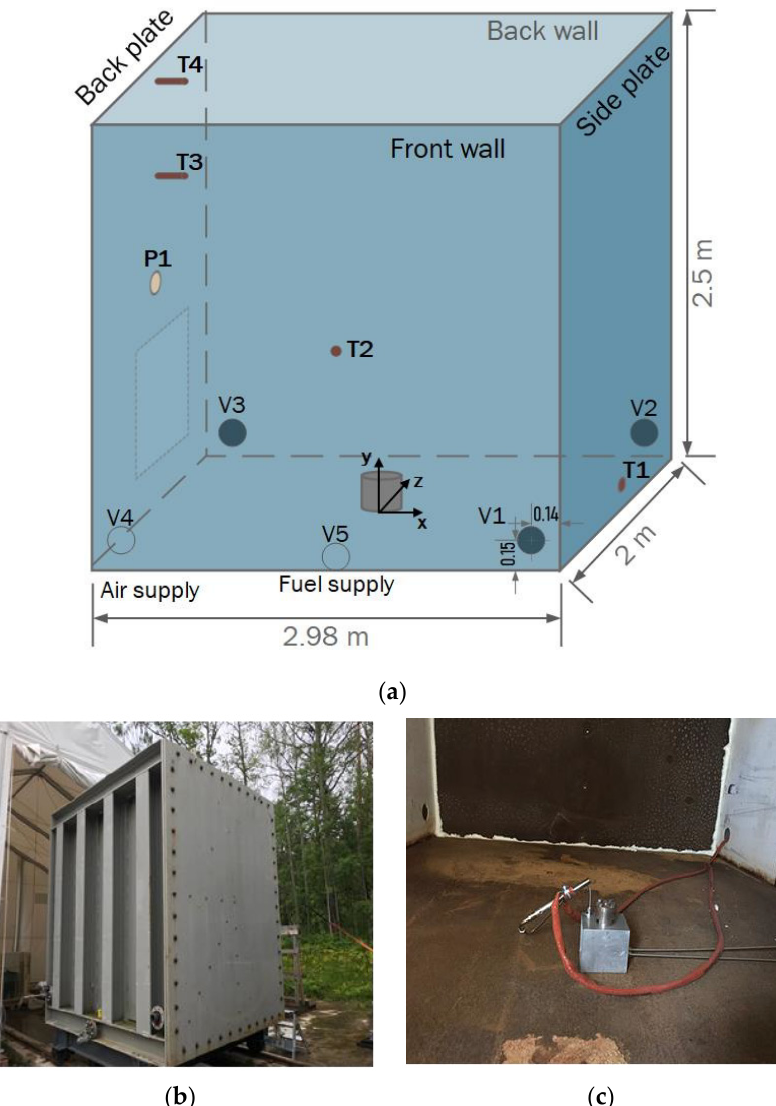
Figure 1. Experimental facility: ( a )—sketch of the facility with the location of vents (V1–V3), air supply (V4), fuel supply (V5), pressure transducer (P1) and thermocouples (T1–T4); ( b )—picture of the facility front wall; ( c )—location of stand with hydrogen release nozzle and propane pilot flame [9].